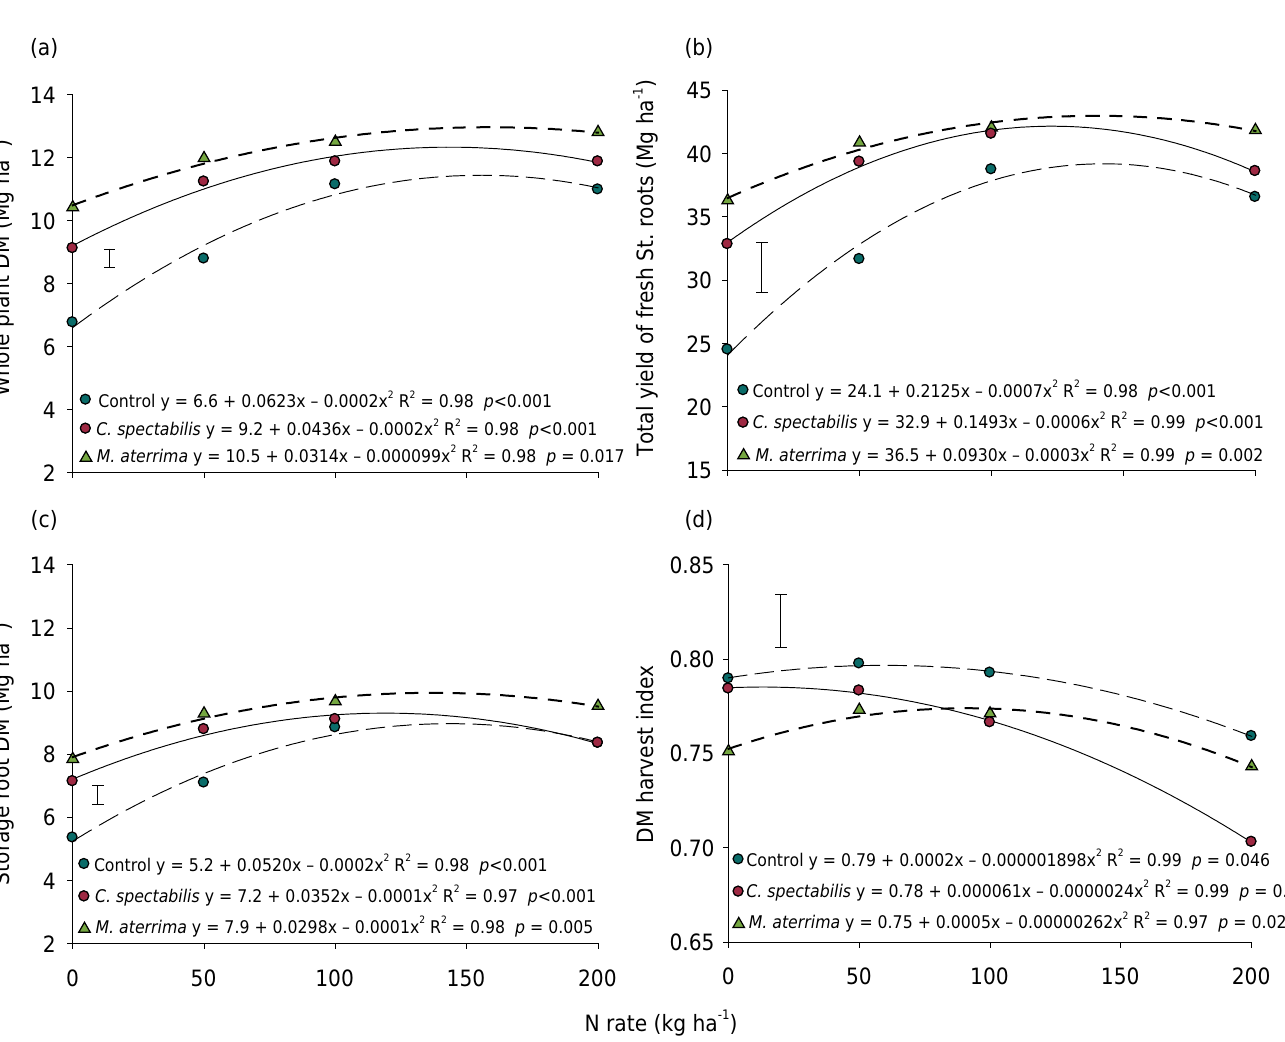
Figure 3. Whole plant dry matter (DM) accumulation at the harvest (a), total yield of fresh storage roots (b), storage root DM yield at the harvest (c), and DM harvest index (d) of sweet potato in response to green manures cultivation and N application rate. Vertical bars represent the least significant difference at p≤0.05 according to LSD test. Data are the means of the two agricultural